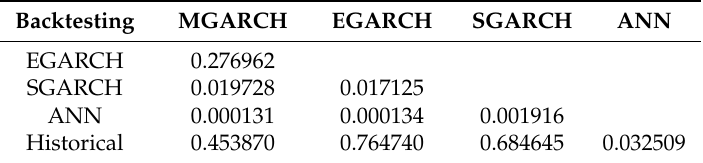
Table A3. T -Test Results ( p -values) on Forecasting Errors.